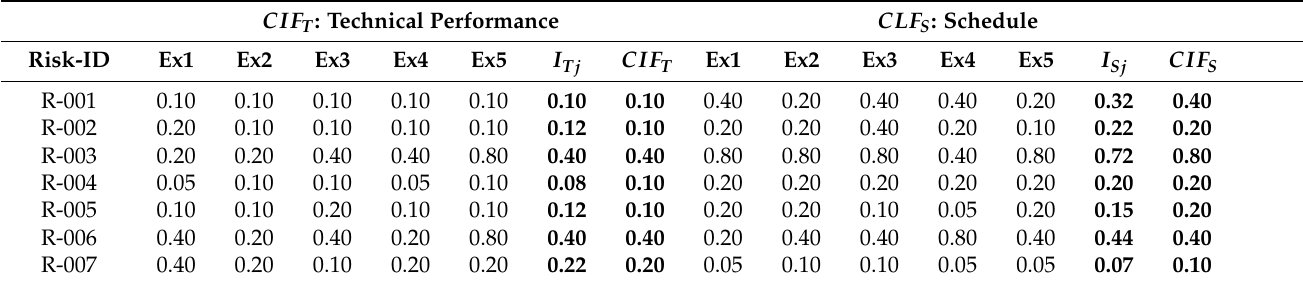
Table 10. Composite Impact Factors ( CIFj